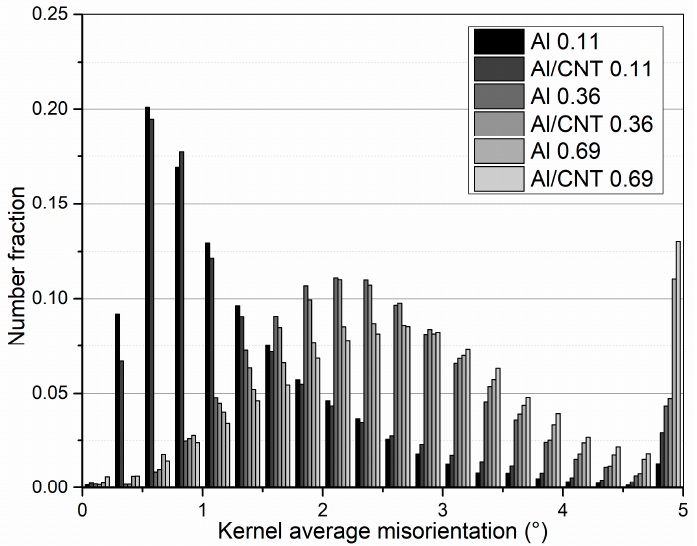
Figure 7. Distribution of Kernel average misorientation (KAM) for Al and Al/CNT samples, cold rolled to strains of 0.11, 0.36, and 0.69.